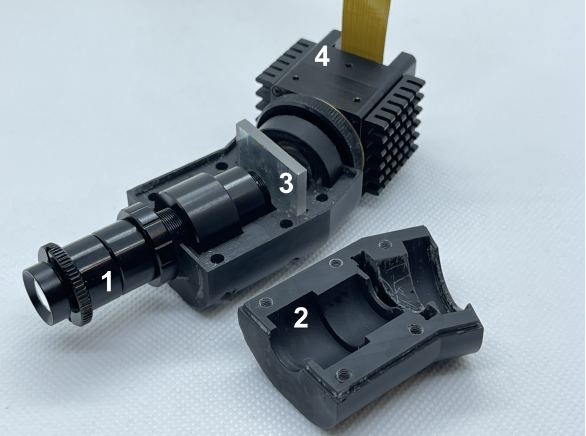
Figure 4. The split halves of the enclosure showing the S-mount collimator tube (1), which is fixed to the collimator mount (2). A small grub screw ensures that the tube resists rotation after assembly. The diffraction grating (3) splits the light into its component colours and is received by the XIMEA camera